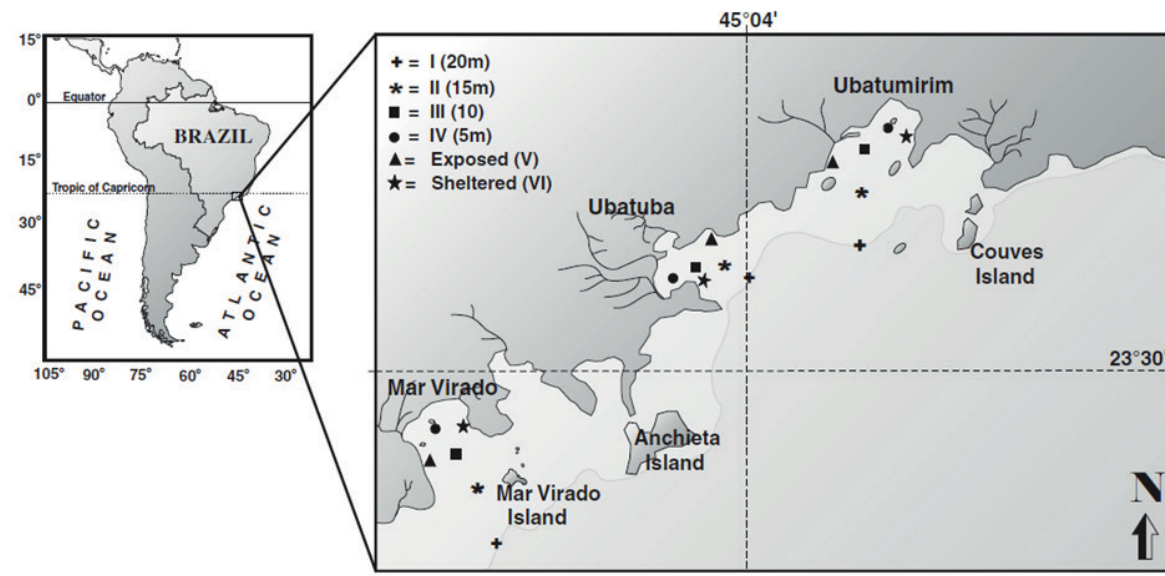
Figure 1. Map of Ubatuba on the coast of São Paulo, showing the three bays and their respective sampling